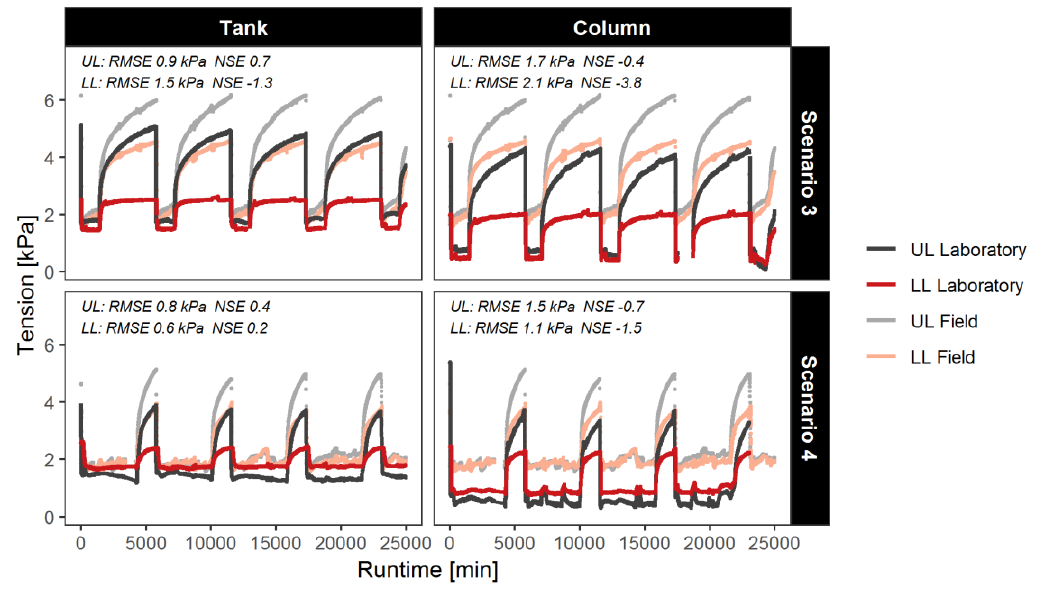
Figure 4. Tension measurements of laboratory experiments (tank and column) compared to field measurements in 0.3 m (UL — upper layer) and 0.7 m (LL — lower layer) depths for scenarios 3 and 4.